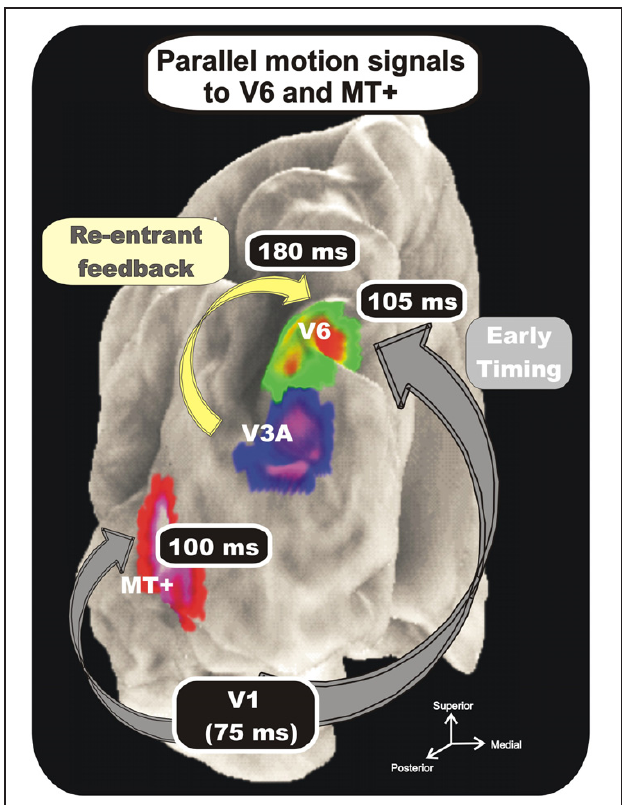
FIGURE 9 | Combination of VEP and fMRI data. Group-averaged Imaging results. Regions more activated in the coherent or incoherent motion conditions (contrasts C-I and I-C) are indicated on the cortical surface using text labels (V6, V3A, and MT + ) together with labels about their response timing. Results are displayed together on the semi-inflated cortical surface reconstruction of the left hemisphere of the average brain. Numbers indicate time of occurrence of VEP signals. Modified from Pitzalis et al. (2012b).